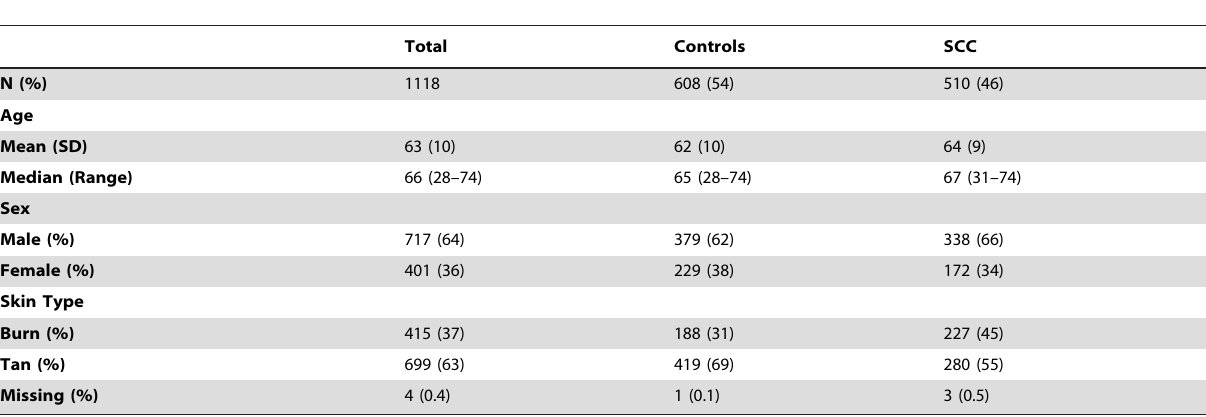
Table 1. Demographic characteristics of the study